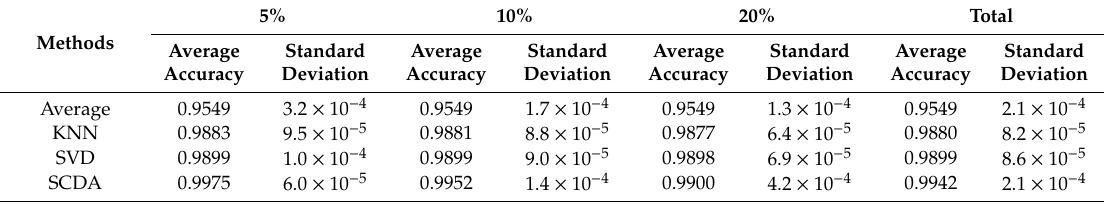
Table4. PerformancecomparisononHLAgenotypesofEASsuperpopulationatthreemissingscenarios.